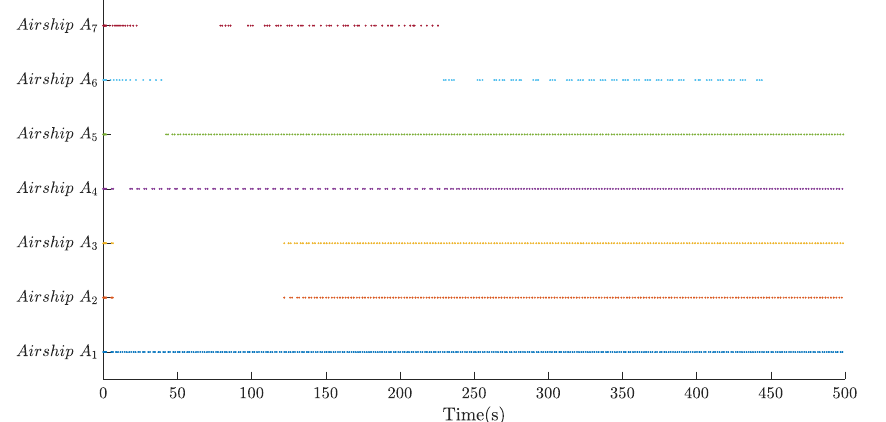
Figure 10. Event-triggered instants in former 500 s.